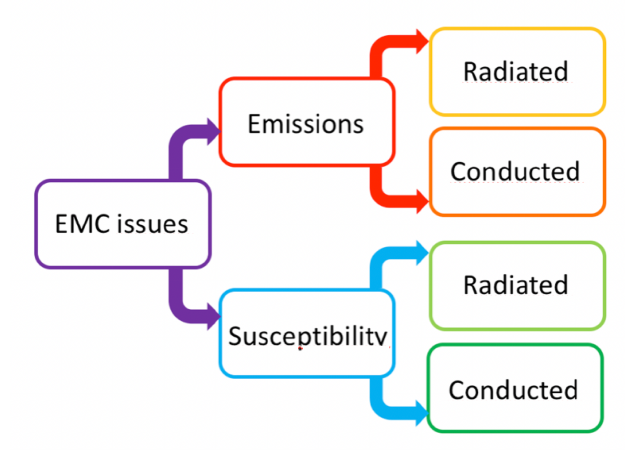
Figure 1. EMC issues.